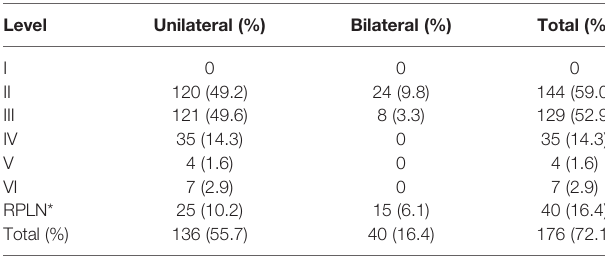
TABLE 2 | The incidence of lymph nodes metastasis at each level among 244